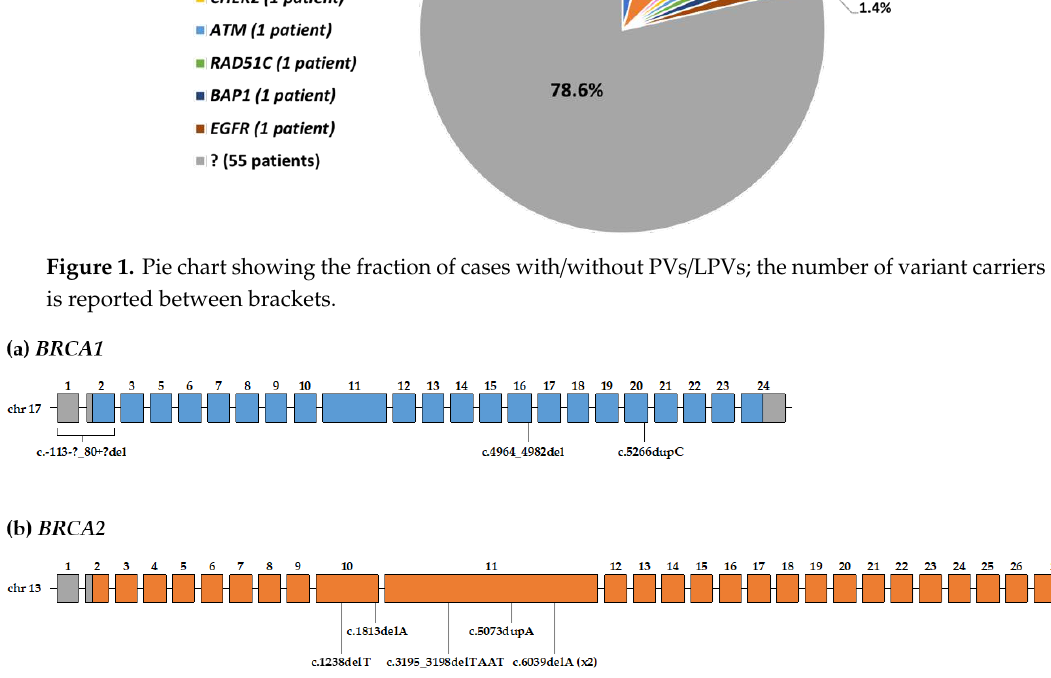
Figure 2. ( a ) Schematic representation of the BRCA1 gene (transcript NM_007294) and localization of the three PVs identified in our cohort; ( b ) schematic representation of the BRCA2 gene (transcript NM_000059) and localization of the six PVs identified in our cohort. Exons are represented with grey boxes for non-coding exons and with blue and orange boxes for coding exons of BRCA1 and BRCA2 , respectively; the exon numbering has been reported above the exons (the traditional exon numbering of BRCA1 gene lacks exon four that has not been represented).